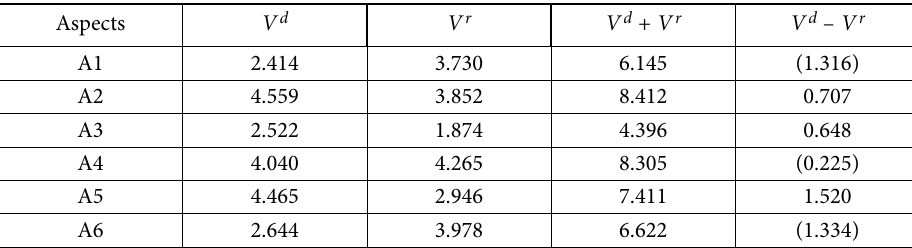
Table 8. Sum of influences given and received on the aspects